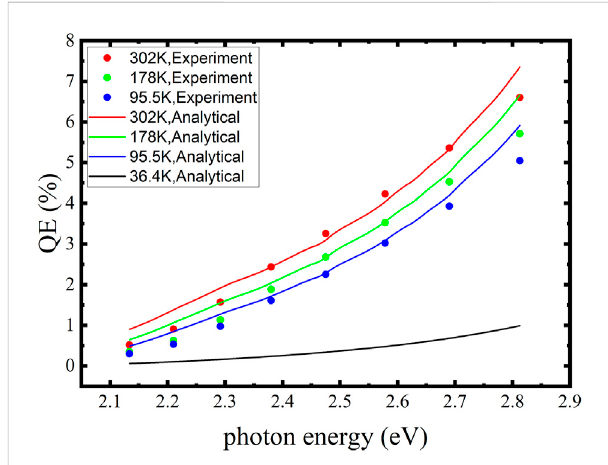
FIGURE 2 Comparison oftheanalyticaland experimental resultsofspectral responses for the K-Cs-Sb photocathode at different temperatures. The black line represents the calculated spectral response at 36.4 K.